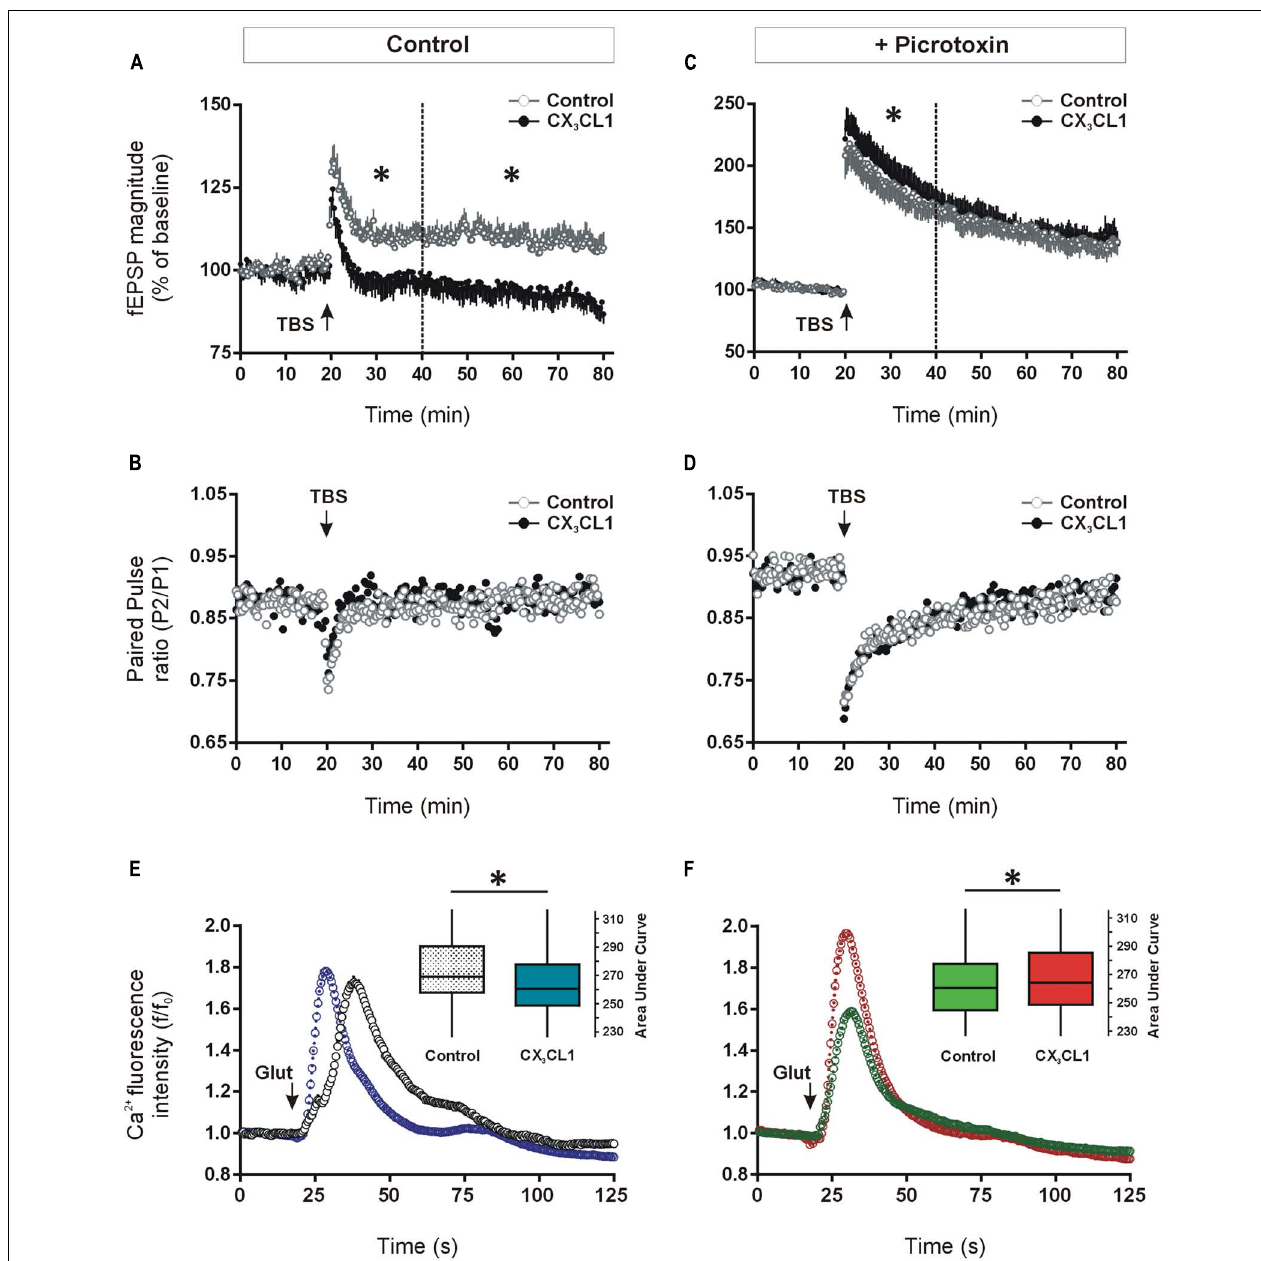
effect on late LTP. (D) Shows the paired-pulse ratio between the first and second stimulations (50 ms interval) in the LTP experiment in C . (E) Shows the effect of CX 3 CL1 on glutamate-induced calcium influx in the CA1 region of organotypic hippocampal slices cultured for 21 DIV. Pre-treatment of slice cultures with CX 3 CL1 (500 pM) for 15 min prior to glutamate exposure reduced calcium influx in the CA1 region (Mann–Whitney U test; p < 0.001). Box plot inset shows the area under the curve (AUC) for the whole experimental time-course. CX 3 CL1 (500 pM) was present for the duration of the time period shown. (F) The effect of CX 3 CL1 on glutamate-induced calcium influx in the CA1 region of organotypic hippocampal slices in the presence of picrotoxin. Pre-treatment of slice cultures with CX 3 CL1 (500 pM) and picrotoxin (100 μ M) versus picrotoxin alone (control) for 15 min prior to glutamate exposure enhanced calcium influx in the CA1 region (Mann–Whitney U test; p < 0.001). Box plot inset shows the area under the curve (AUC) for the whole experimental time-course. CX 3 CL1 (500 pM) and/or picrotoxin (100 μ M) were present for the duration of the time period